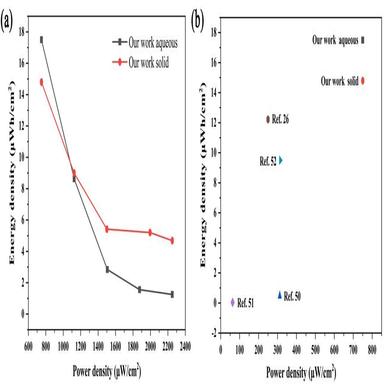
Ragone plots (a) this work, (b) this work comparing with other reported supercapacitors in the literature.